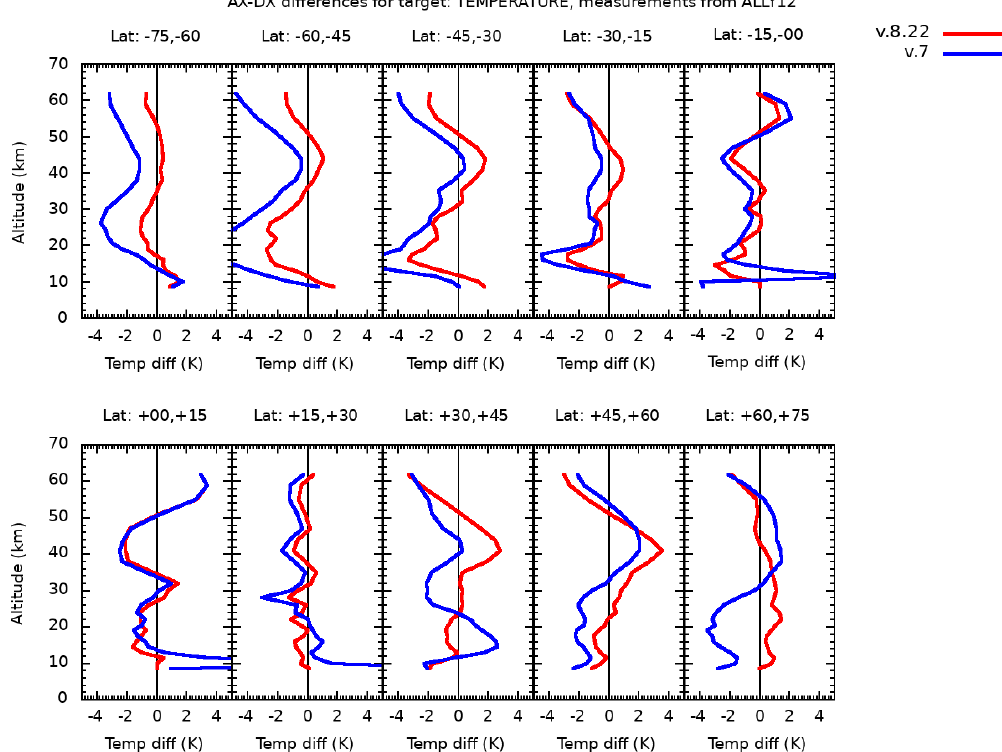
Figure 3. Temperature ascending–descending average difference profiles for V7 (blue) and V8 (red) MIPAS/ESA products. Averaging extends to the measurements acquired in the month of December of the years 2006 to 2011 (OR part of the mission). The different panels show different latitude bands as indicated on the top of the